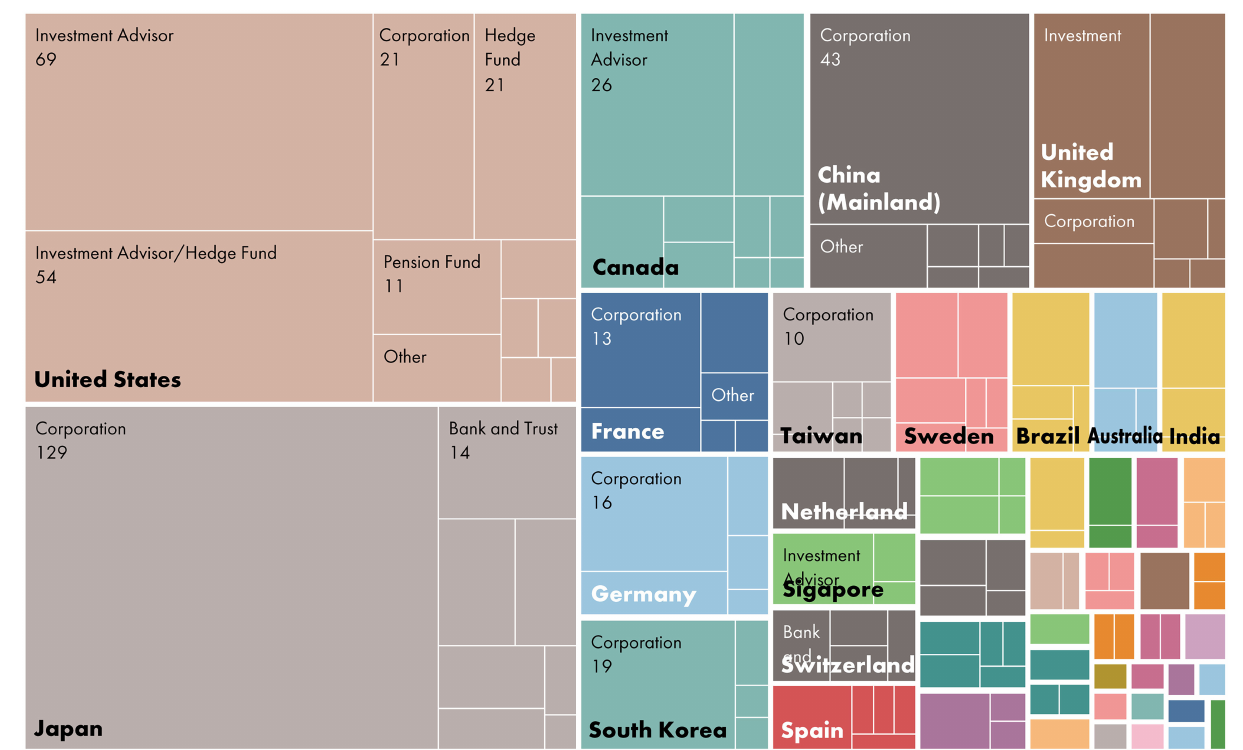
Frontiers in Sustainability |